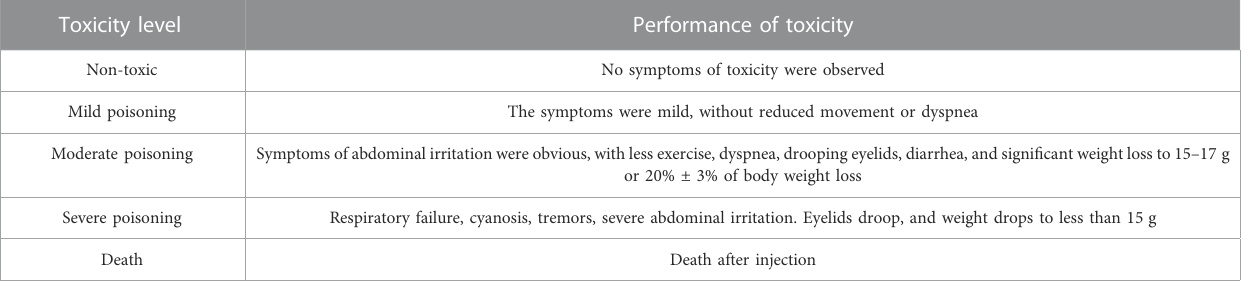
TABLE 1 Evaluation criteria for systemic toxicity.